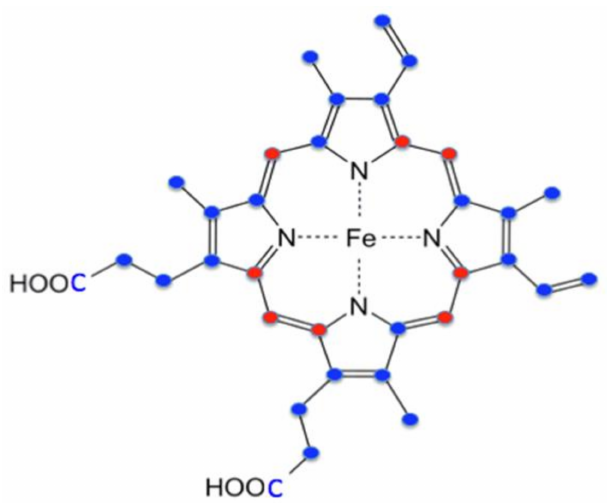
Figure 4. Origin of heme carbon atoms. Red-colored carbons are derived from glycine. Blue-colored carbons are derived from succinyl